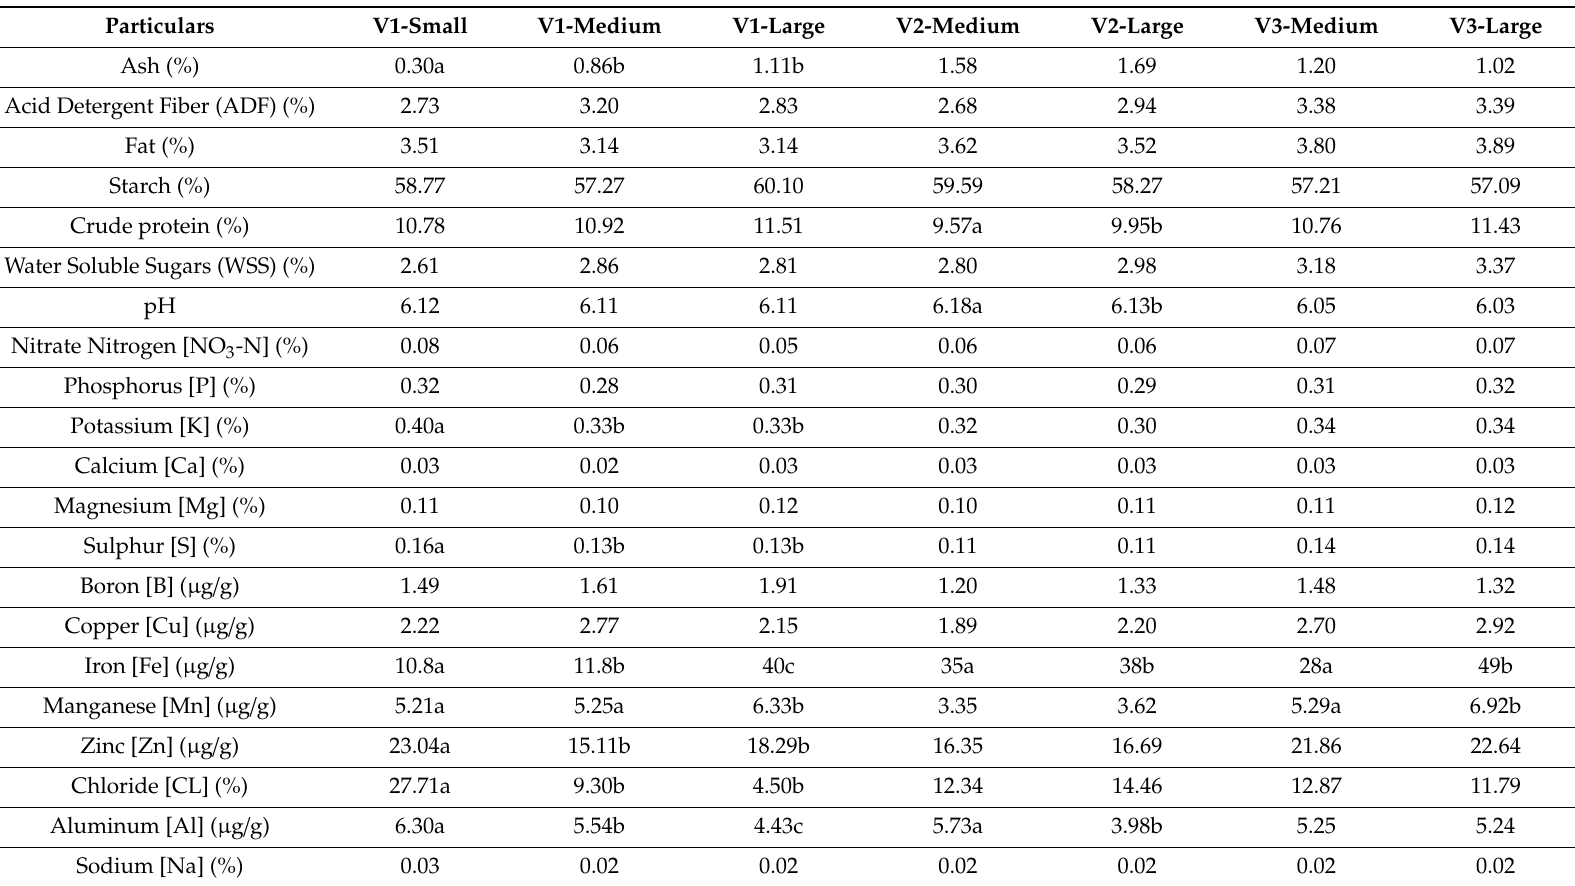
Table 2. Seed chemical profile of the three corn hybrid